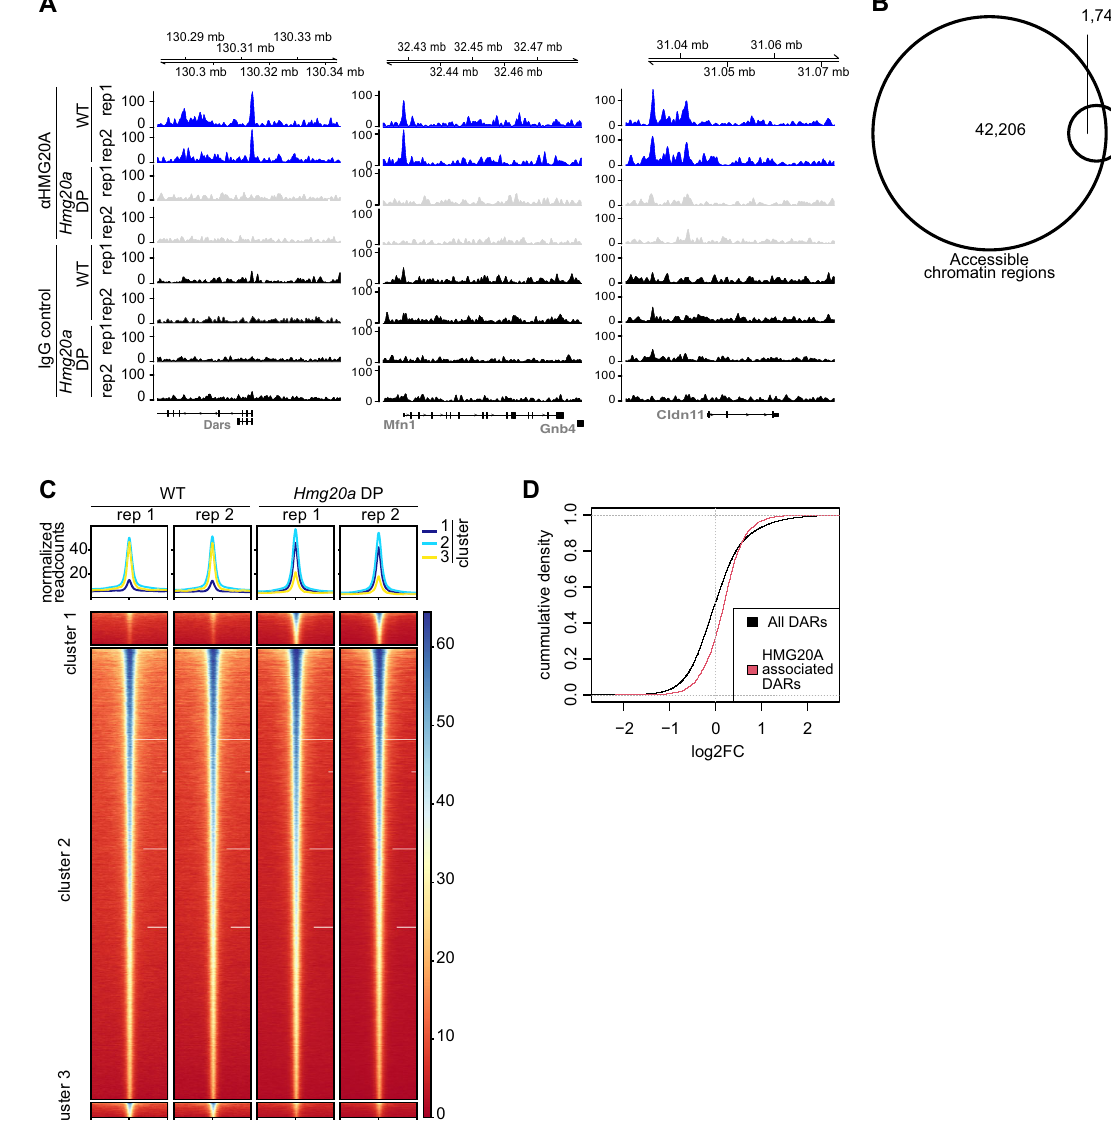
Fig. 7 | HMG20A is enriched at open chromatin regions and affects chromatin accessibility in mESCs. A Genome browser snapshots of representative HMG20A binding regions, as identi fi ed by CUT&RUN-seq of primed stage WT (blue) or Hmg20a DP clone #26 (light gray, negative control) mESCs. IgG antibody was used as negative control (black). Shown are two independent replicates (rep). B Venn diagram depicting overlay of CUT&RUN identi fi ed HMG20A binding sites with